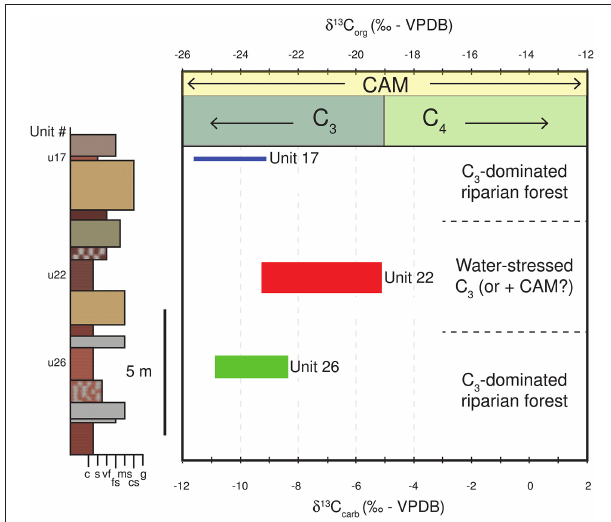
FIGURE 11 | Range in δ 13 C values measured from rhizoliths in Units 26, 22, and 17, shown in stratigraphic position next to the lower part of the stratigraphic column of the trench (units 16–30), and compared to the known ranges of carbon isotopic composition of plant biomass (C 3 , C 4 , and CAM plants). Data indicate that the paleoenvironment at Loperot changed from a purely C 3 riparian woodland (Unit 26), to a water-stressed C 3 - (or arid-adapted CAM-plant) dominated environment (Unit 22), and back to C 3 riparian woodland (Unit